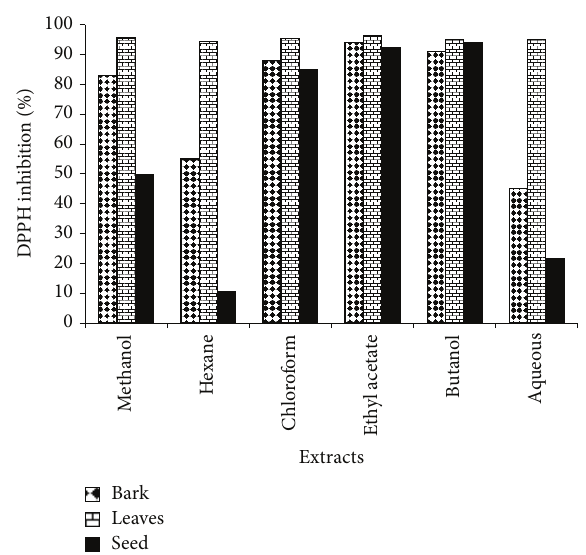
Figure 1: DPPH inhibition potential of different extracts of L. pulverulentus